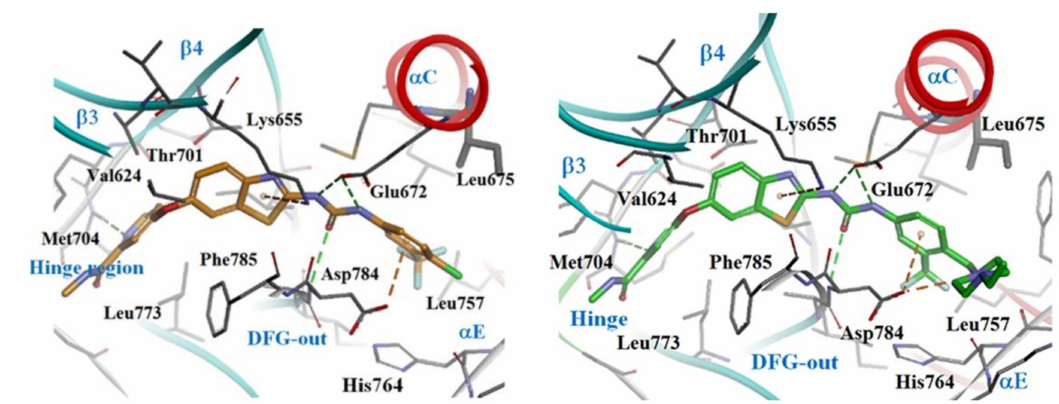
Figure 15. Docking models of compounds 36 (orange) and 38 (green) into DFG-out conformation of DDR1. Reprinted with permission from Ref. [146].